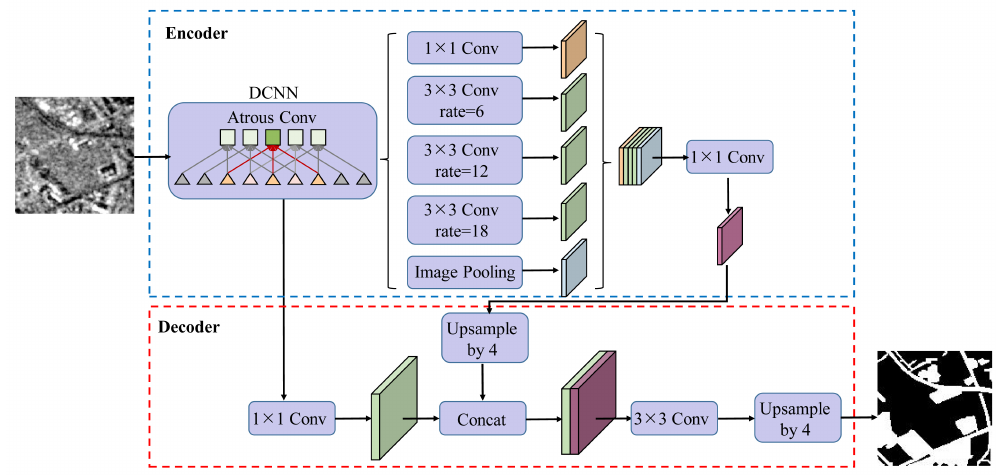
Figure 4. The basic structure of Deeplabv3+